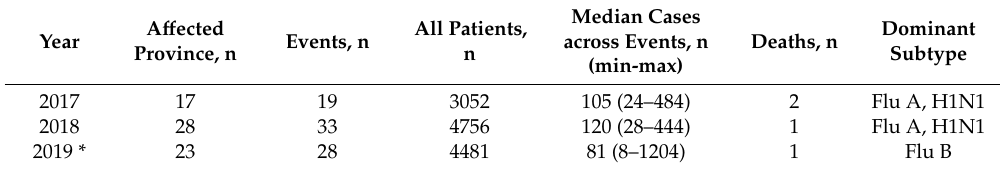
Table 1. Incidence of influenza outbreaks in prisons in Thailand,